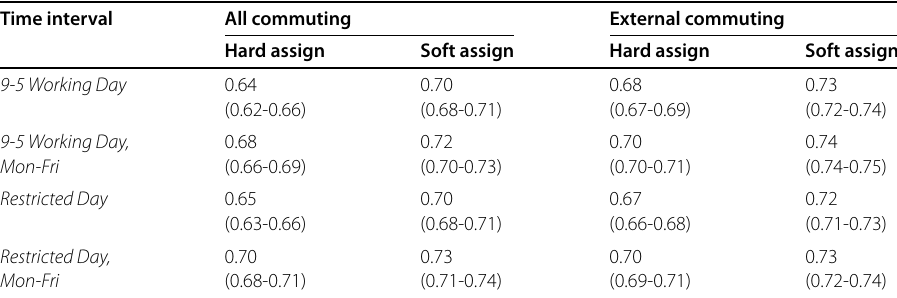
Table 3 CPC for Twitter-based estimates using different time-based heuristics, for both hard and soft assignment techniques. Brackets contain bootstrapped 95% confidence